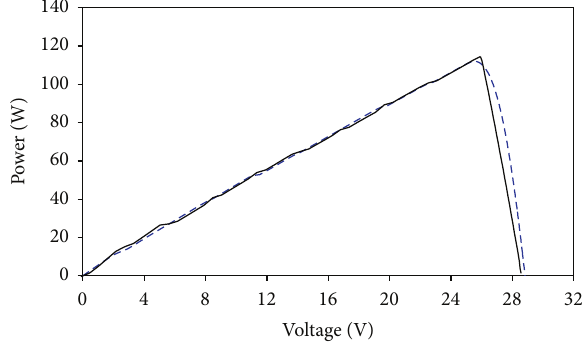
Figure 13: Matlab simulated P-V curve of optimized array (blue dashed line) is compared to P-V curve of FPM simulation curve (black